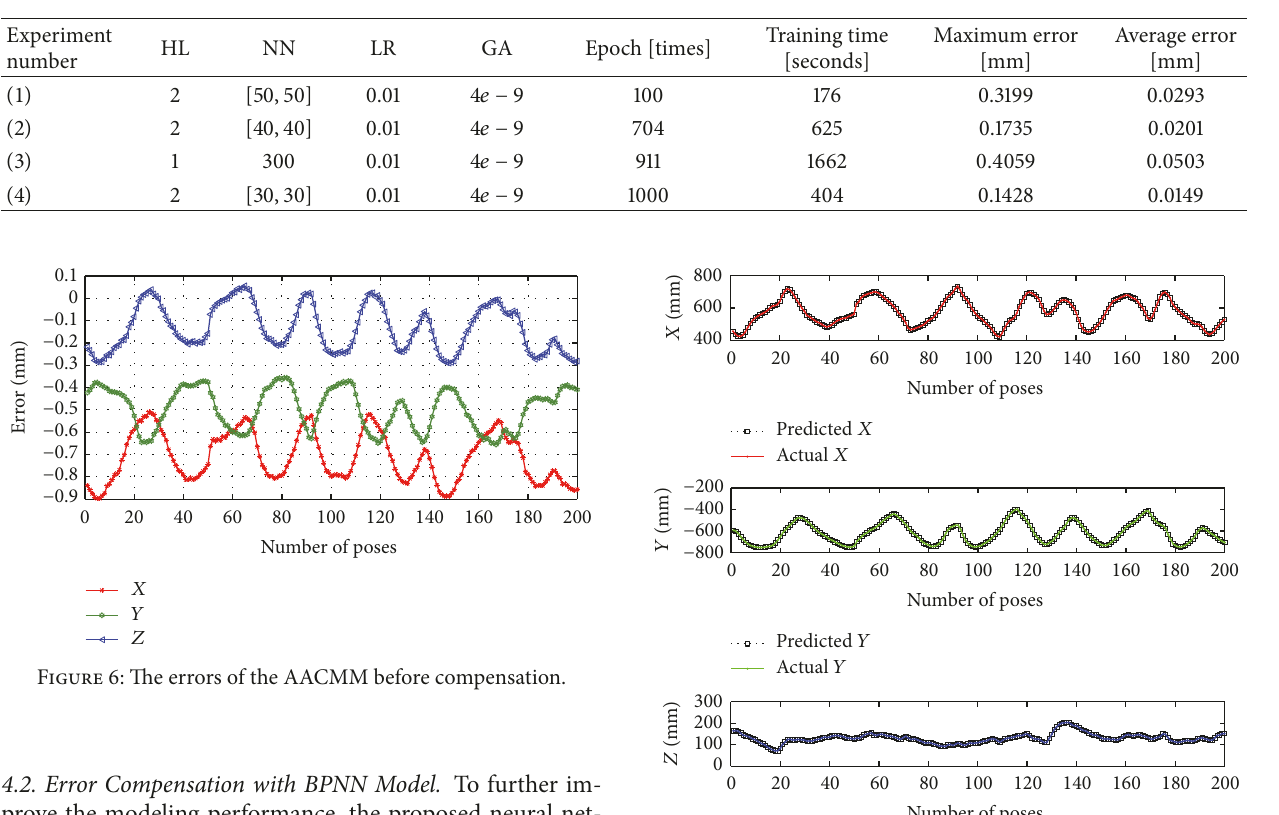
of the error we found that there are 3 coordinate errors which are greater than 0.08 mm and 13 coordinate errors which are greater than 0.05 mm in the 600 coordinates (200 groups of poses). We have the conclusion that the prediction error is less than 0.05 mm in the principle of 2 Sigma [5]. By